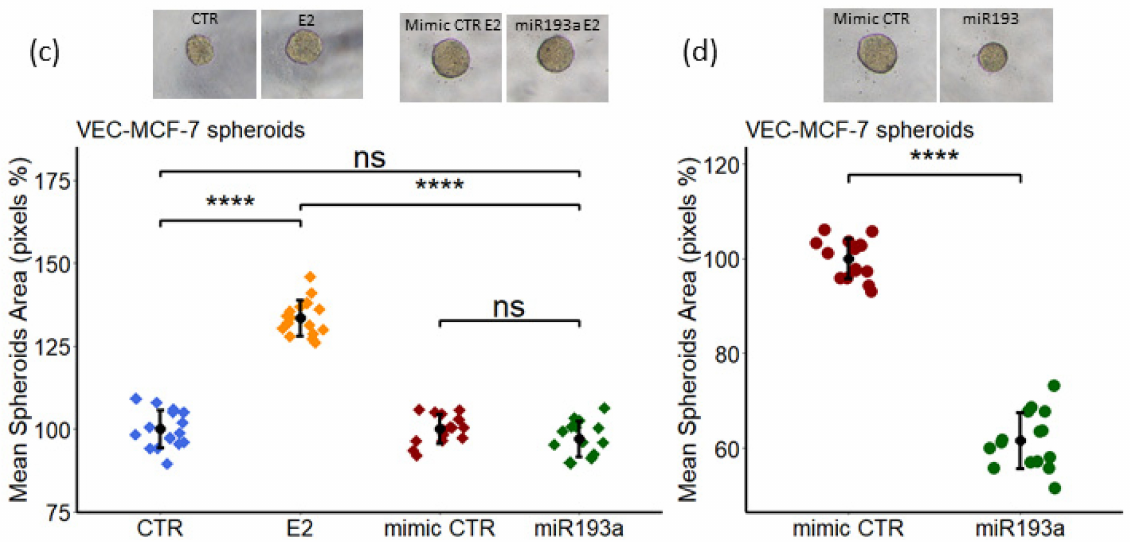
Figure 12. E2 and FCS induced spheroid (MCF-7 and MCF-7+VEC) growth is abrogated by miRNA193a-3p. Pixel analysis was performed to calculate total area of spheroids formed with MCF-7 cells alone ( a , b ) or in combination with VECs ( c , d ). Cells were transfected with 25 nM of mimic CTR and miRNA193a using Lipofectamine2000 and seeded in U-bottom plate and fed treat- ment medium containing 10 nM E2 or 2.5% FCS. Pictures of spheroids were taken on Day 4 and analyzed using ImageJ software to calculate spheroid area. p < 0.0001 **** compared to the respective control. Data represent the mean ± SD of 15 spheroids. ns = not